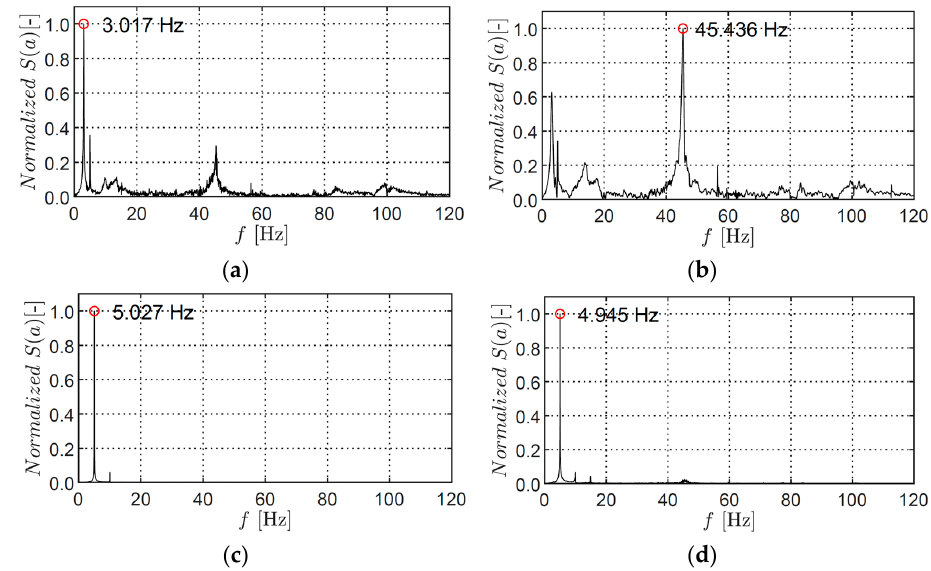
Figure 15. Dominant coupled response from Setup 1: ( a ) vertical at U = 0 m/s; ( b ) vertical at U = 10 m/s; ( c ) torsional at U = 0 m/s; ( d ) torsional at U = 10 m/s.